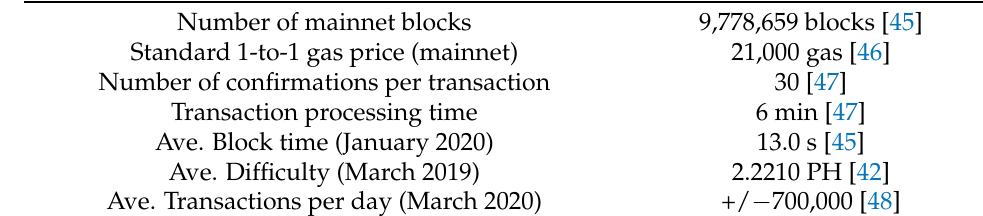
Table 1. State of Ethereum